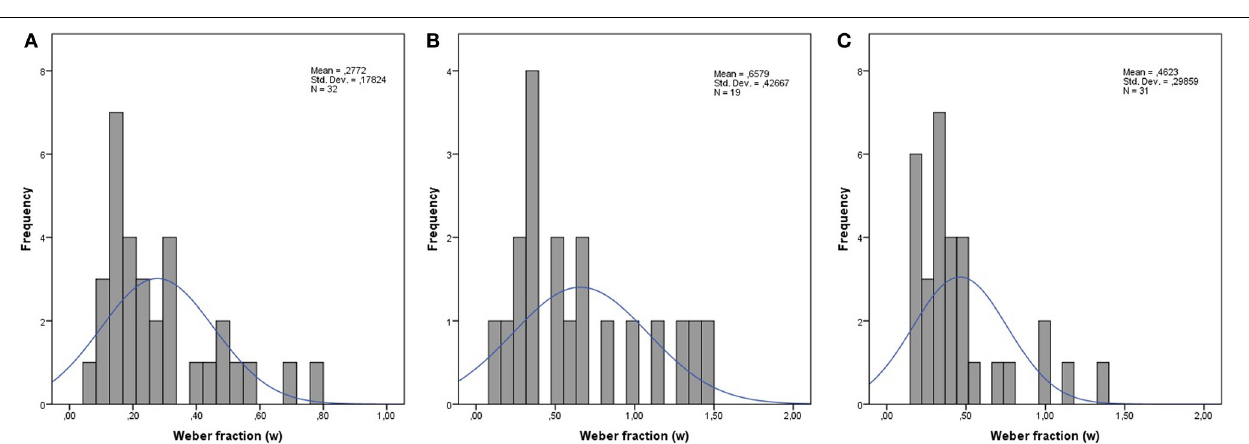
FIGURE 2 | Histogram of internal Weber fractions on the time discrimination task for (A) TA4, (B) DD and (C) TA2.